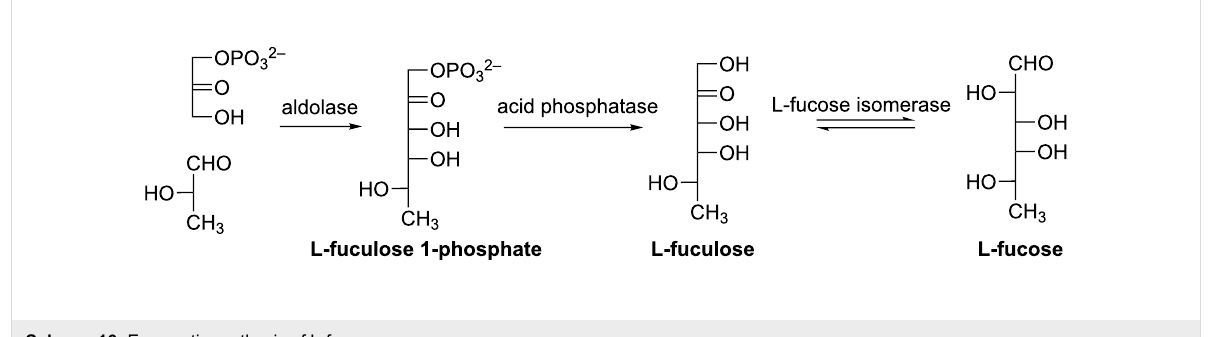
Scheme 16: Enzymatic synthesis of L-fucose.